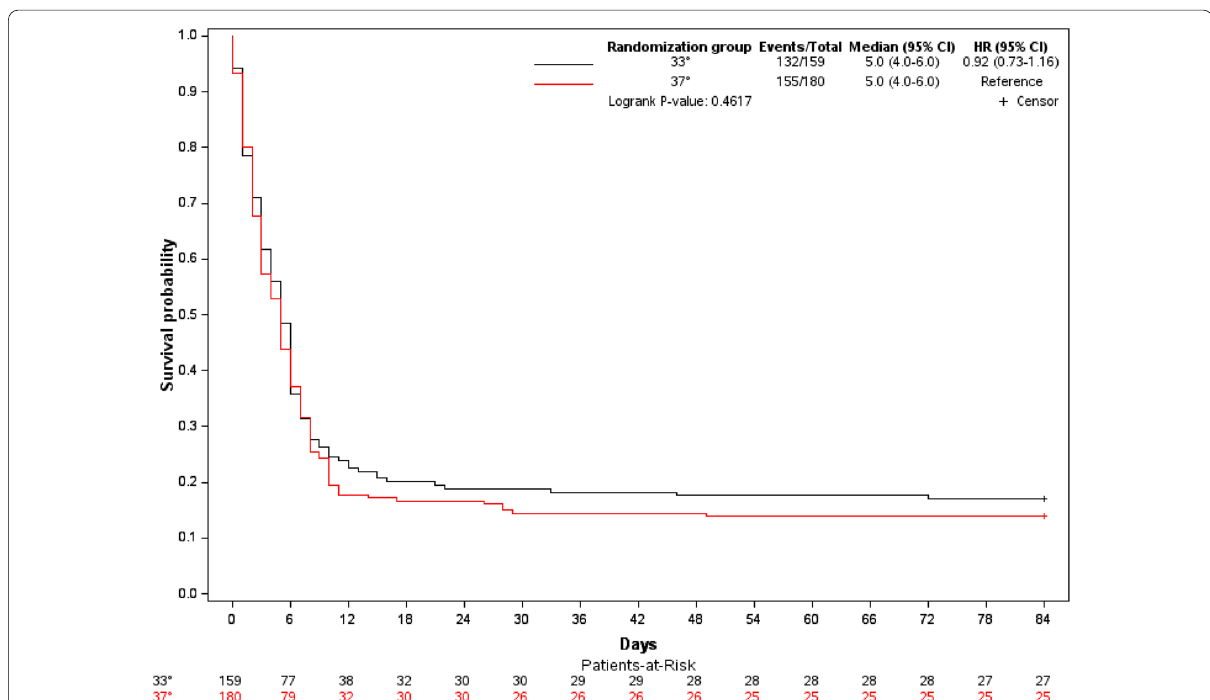
Fig. 1 Probability of survival to 90 days according to temperature allocated in the subgroup of patients with PRS. HR: hazard ratio; 95% CI: 95% confidence interval. PRS: postresuscitation shock